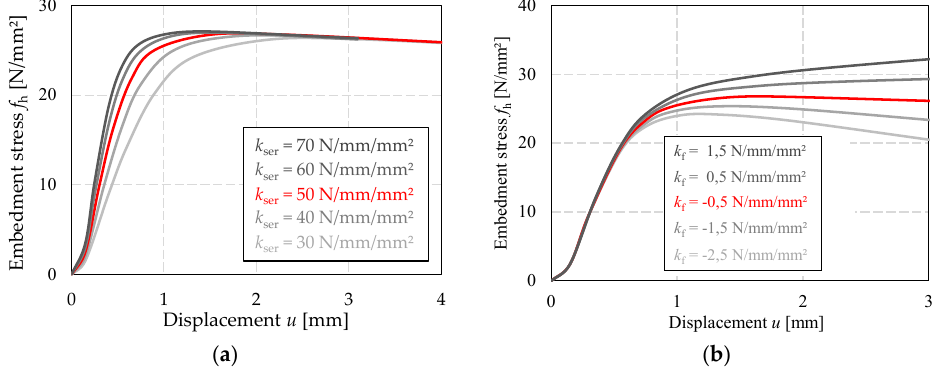
Figure 13. (a) Comparison of numerical embedment curves in timber for different values of k ser [34]; (b) Comparison of numerical embedment curves in timber for different values of k f [34].